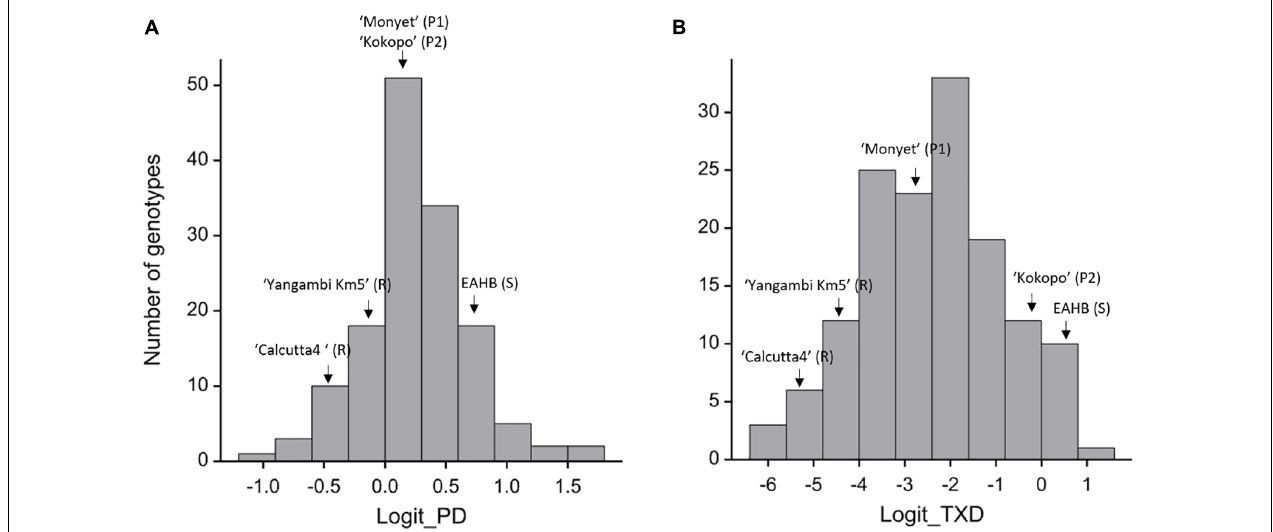
FIGURE 2 | Distribution of the adjusted means for peripheral damage (PD) [logit_PD (A) ] and total cross-section damage (TXD) [logit_TXD (B) ] in the F 1 hybrids, their female (P1) and male (P2) parents, and the resistant (R) and susceptible (S) checks. EAHB = East African Highland Bananas, here meaning “Nakyetengu” and “Kabucuragye.”